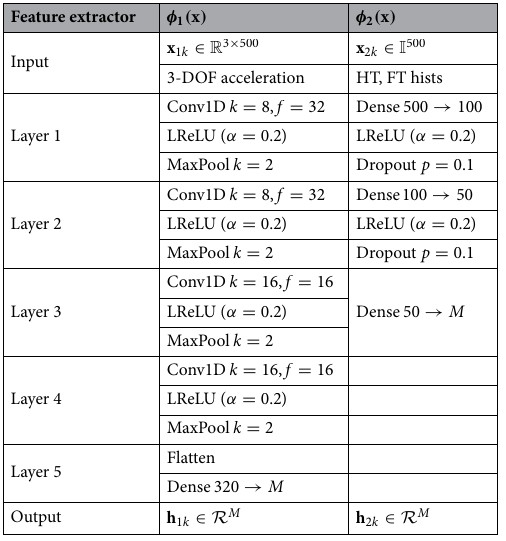
Table 6. The network architectures used for the feature extraction modules φ 1 , φ 2 . k denotes kernel size, f the number of filters in the convolutional layers and M the final embedding dimension. I denotes the unit interval [0, 1].